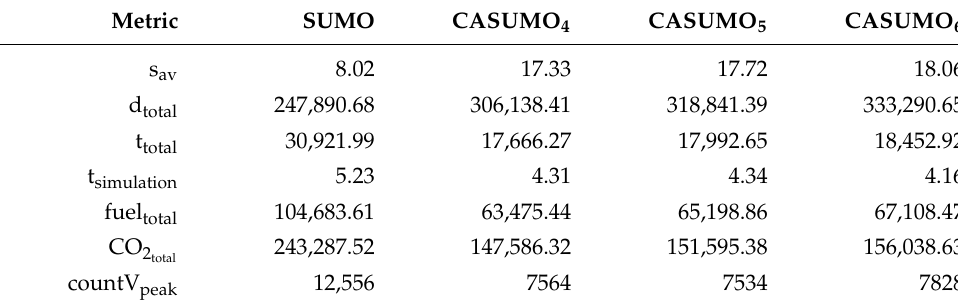
Table 6. Results for 50 K+ simulated vehicles in